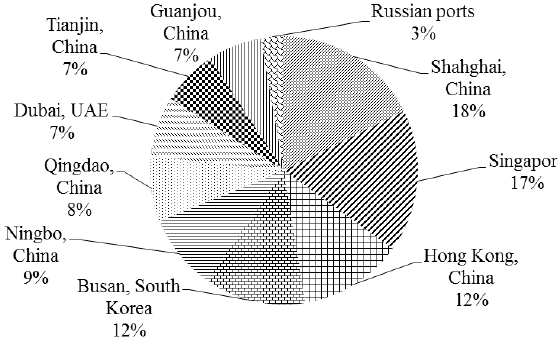
Figure 1: Structure of the world container volume of major seaports in the world in